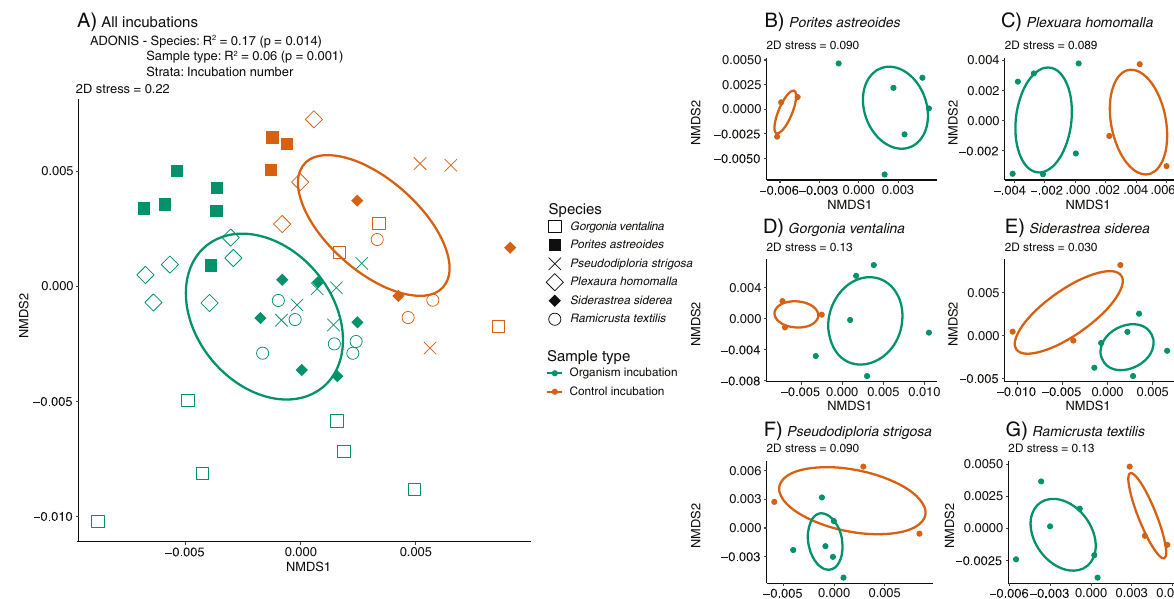
Fig. 2 Non-metric multidimensional scaling analysis (NMDS) of Bray-Curtis dissimilarities calculated for untargeted metabolite features ionized in positive mode are signi fi cantly in fl uenced by species and sample type (organism vs. control incubations). A Global NMDS of control and organism incubations is displayed for all species and the results of the constrained adonis test are included above the plot. B – G NMDSs of control and organism incubations are displayed separately for each coral species. Symbol shape corresponds to species and color corresponds to sample type. Ellipse shapes indicate covariances among samples in each